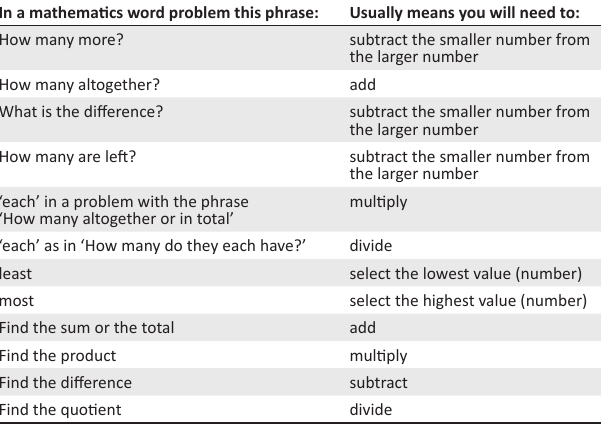
TABLE 1: Translations of word problem